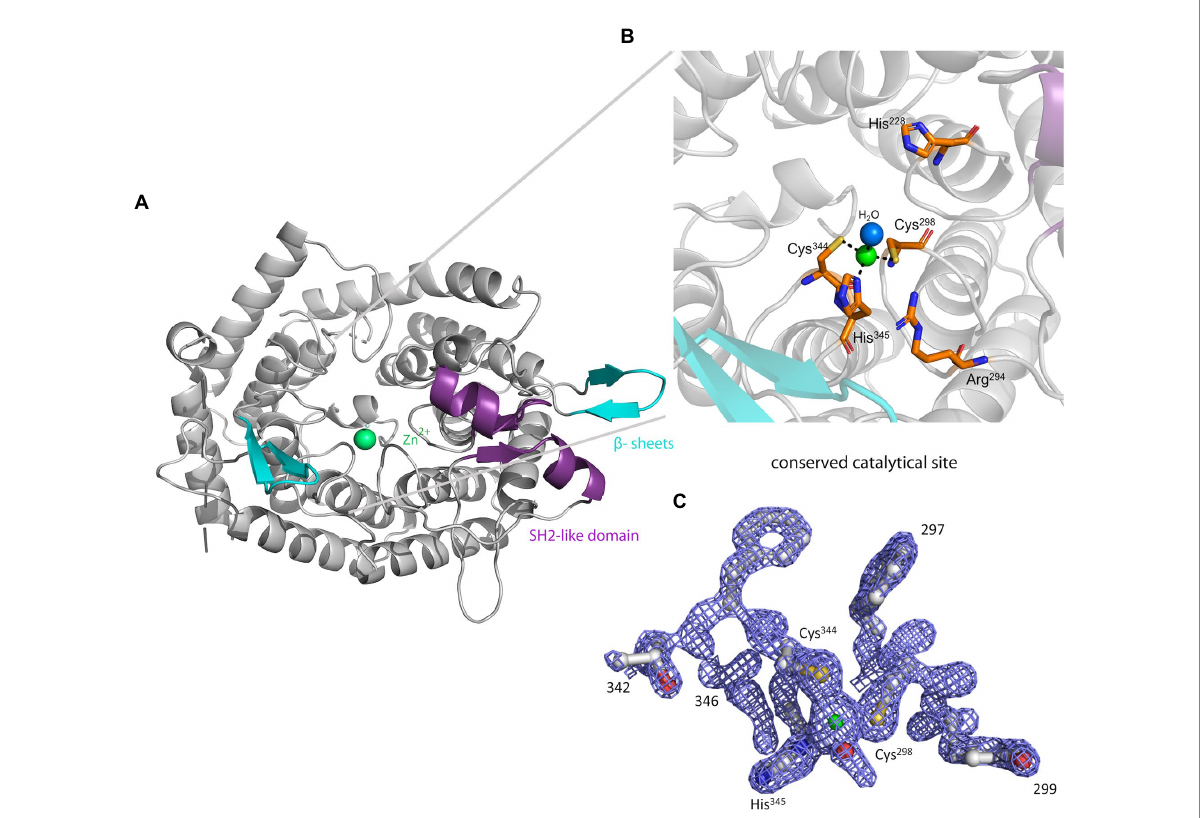
FIGURE 2 The crystal structure of MadC from Clostridium maddingley . (A) The crystal structure of MadC was determined at 1.7 Å. View down the spindle axis of the toroid structure colored in light-gray. The SH2-like domain is colored in magenta and the extending β -sheets are colored in cyan. The green-colored catalytic zinc ion (Zn 2+ ) lies central inside the α , α -toroid structure and is adjacent to a β -sheet and the SH2-like domain. (B) Close- up view of the catalytic site with the toroid in light-gray. Conserved amino acids in the catalytic site are colored in elemental color-coding. Catalytic zinc ion is displayed in green and the coordinated water molecule in light blue. (C) Omit map (contoured at 2 σ ) of residues at catalytical site and zinc ion. Zinc ion is displayed in green. The residues are colored in elemental color-coding. The red sphere beside the zinc ion is a oxygen atom from the water molecule. Cartoons were generated in PyMOL